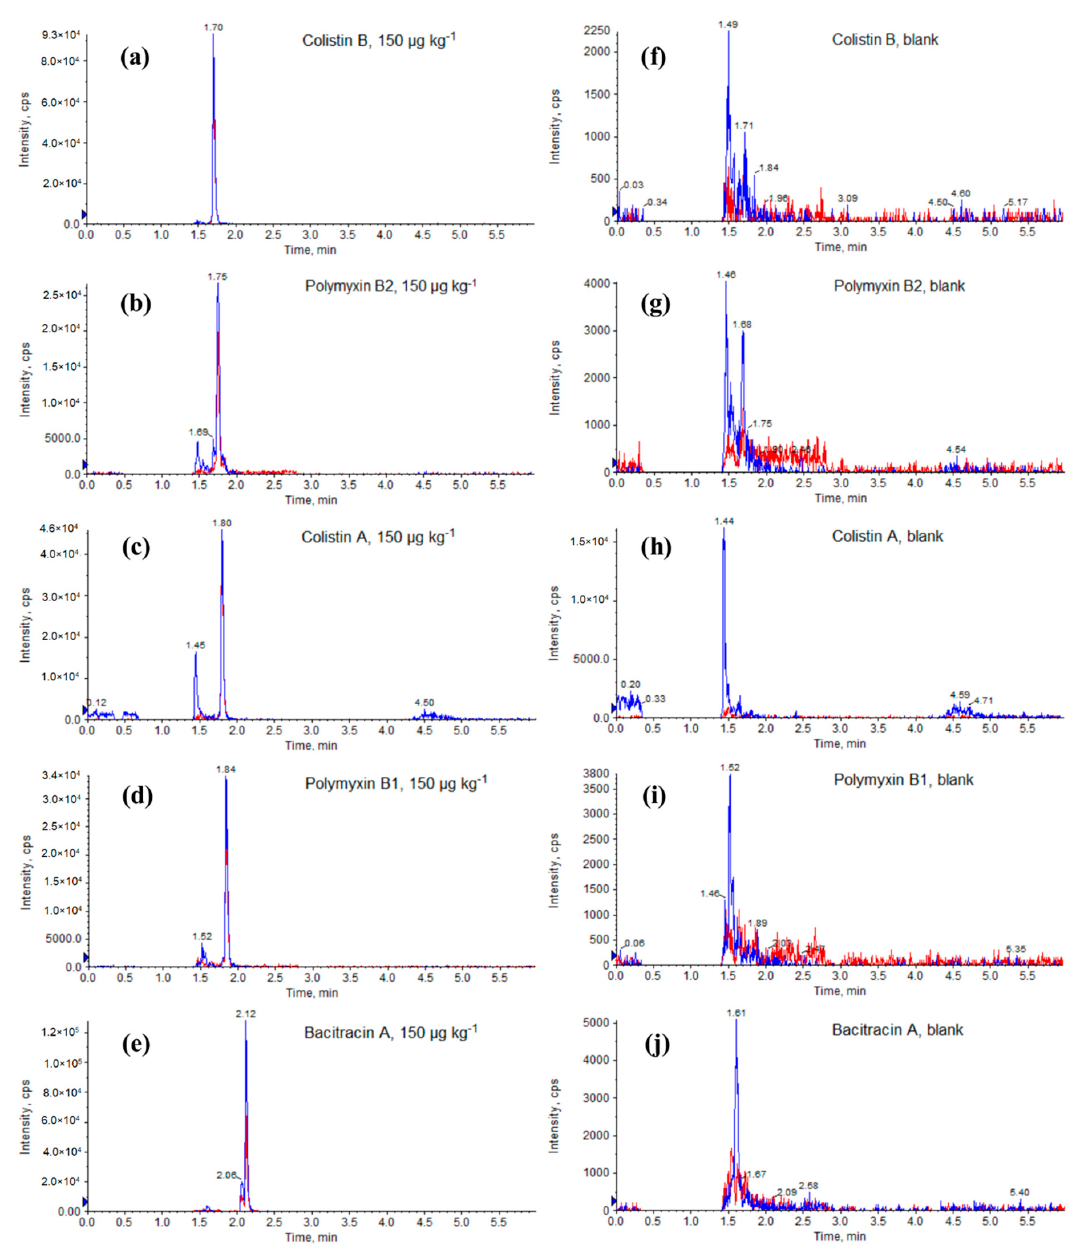
Figure 3. UHPLC-MS/MS chromatograms in multiple-reaction monitoring (MRM) mode of a fortified Figure 3. UHPLC-MS / MS chromatograms in multiple-reaction monitoring (MRM) mode of a fortified swine muscle sample at 150 μ g kg − 1 ( a – e ) and a blank swine muscle sample ( f – j ). swine muscle sample at 150 µ g kg − 1 ( a – e ) and a blank swine muscle sample ( f – j